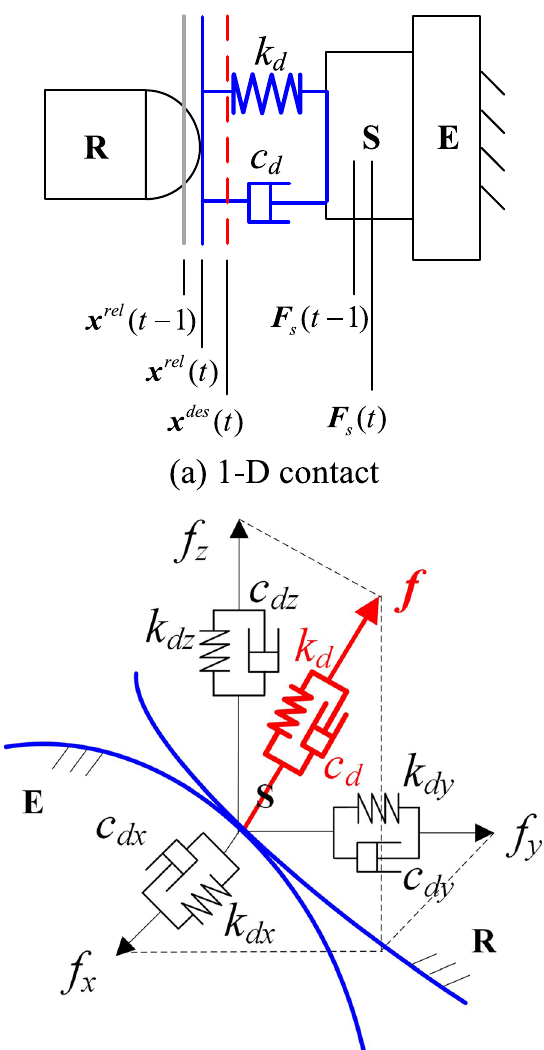
Figure 4 Compliance of the contact